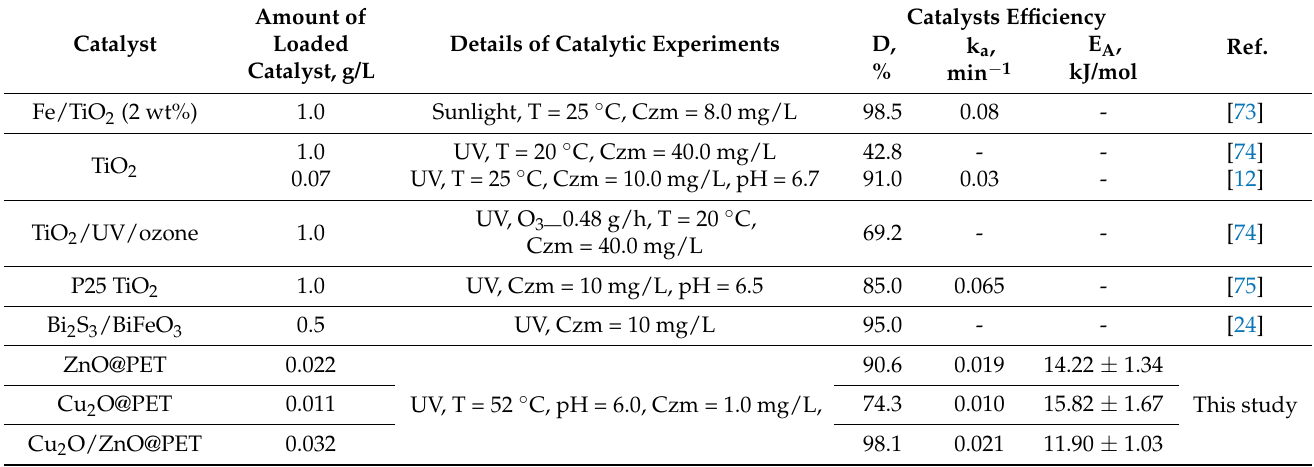
Table 4. Catalytic activity levels of various nanosized materials in the degradation of Czm.